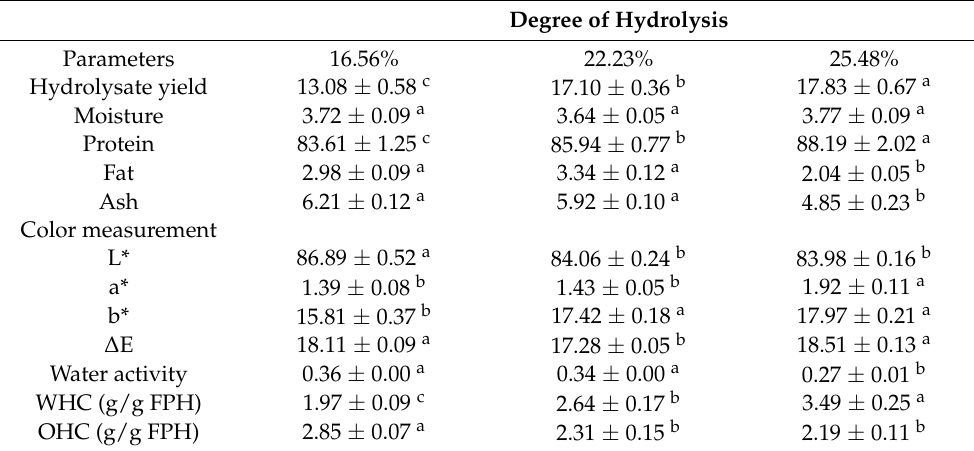
Different letters indicate significantly different values ( p ≤ 0.05). All values represent mean of triplicate mea- surements, mean ± SD (n = 3). L*, a*, b*, ∆ E values are standards of color measurements. L* refers to lightness, ranging from 0 to 100, a* refers to (green to red), and b* refers to (blue to yellow). WHC indicates water-holding capacity (g water/g hydrolysate). OHC indicates oil-holding capacity (g oil/g